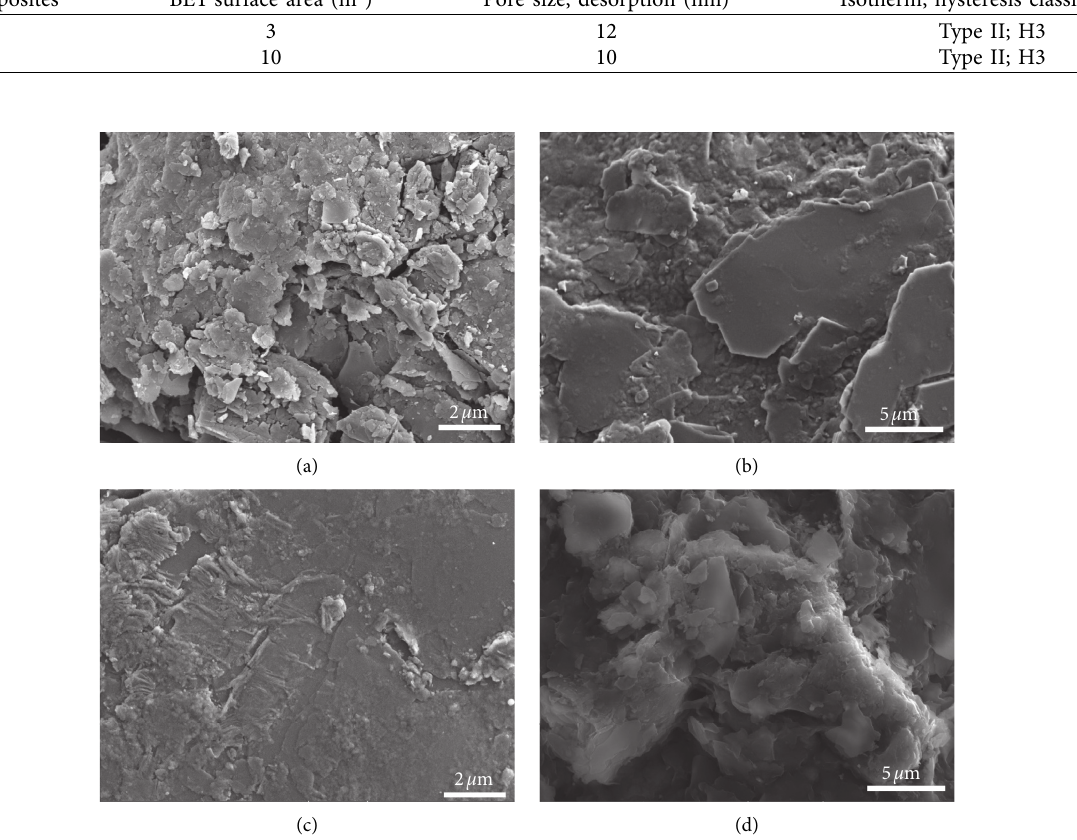
Figure 2: The SEM images of KB and KBNPs: before adsorption ((a) and (c)) and after adsorption ((b) and